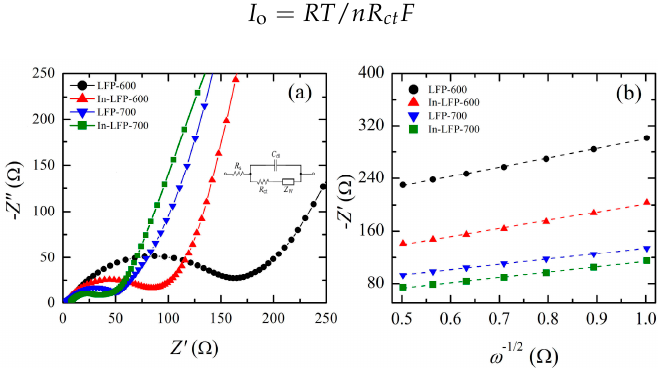
Figure 7. ( a ) Nyquist plots of LFP-600, In-LFP-600, LFP-700, and In-LFP-700 samples and ( b ) plot of Figure 7. (a) Nyquist plots of LFP-600, In-LFP-600, LFP-700, and In-LFP-700 samples and (b) plot of the Z ′ vs. ω − 1/2 in the low frequency region.